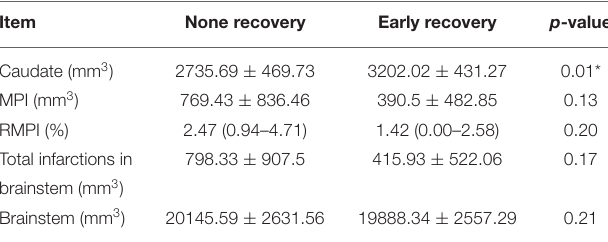
TABLE 4 | Association of neural imaging measurements with early recovery after MT.